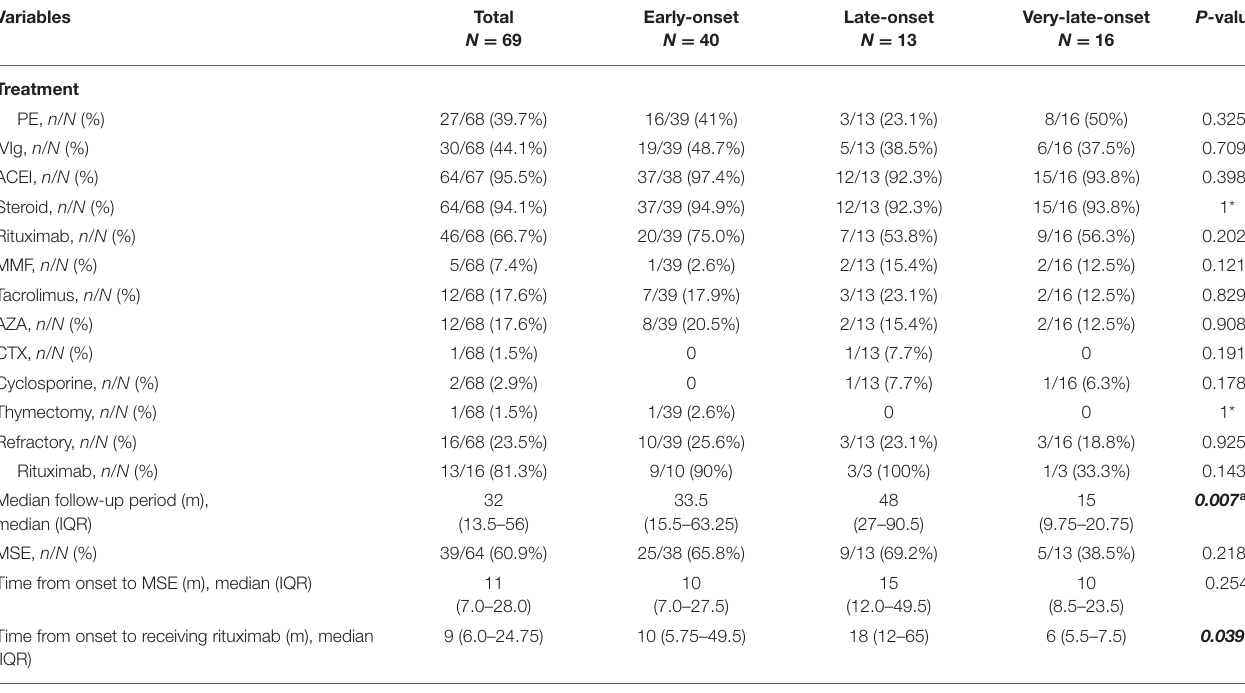
TABLE 3 | Treatment and prognosis in early-onset, late-onset, and very-late-onset MuSK-myasthenia gravis (MuSK-MG).